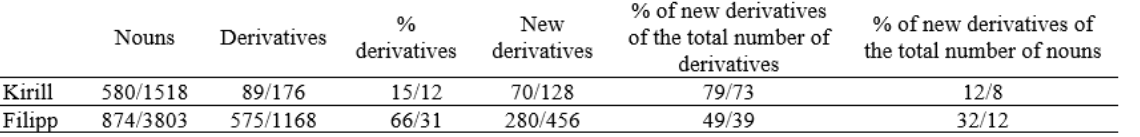
Table 2. Nominal derivatives in child speech (lemmas / tokens)